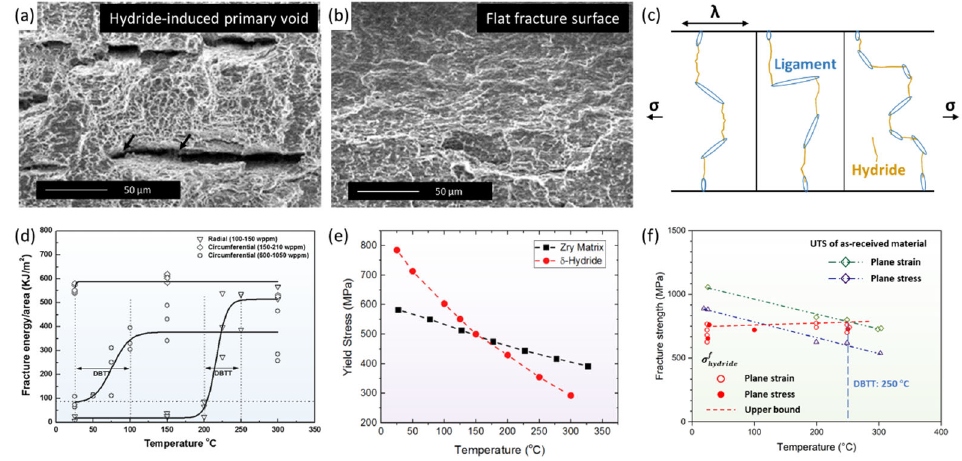
Figure 12. Fracture surface and ductile-to-brittle transition (DBT) mechanism of sample with radial or circumferential hydrides. The fracture surface of Zr-4 containing ( a ) circumferential hydride and ( b ) radial hydride at room-temperature four-point bending test [155]; ( c ) the connectivity of hydride network [6]; ( d ) DBT temperature of Zr-4 with radial and circumferential hydrides [157]; ( e ) yield stress of Zr-4 and circumferential δ hydride vs. temperature [165]; ( f ) fracture strength of radial δ